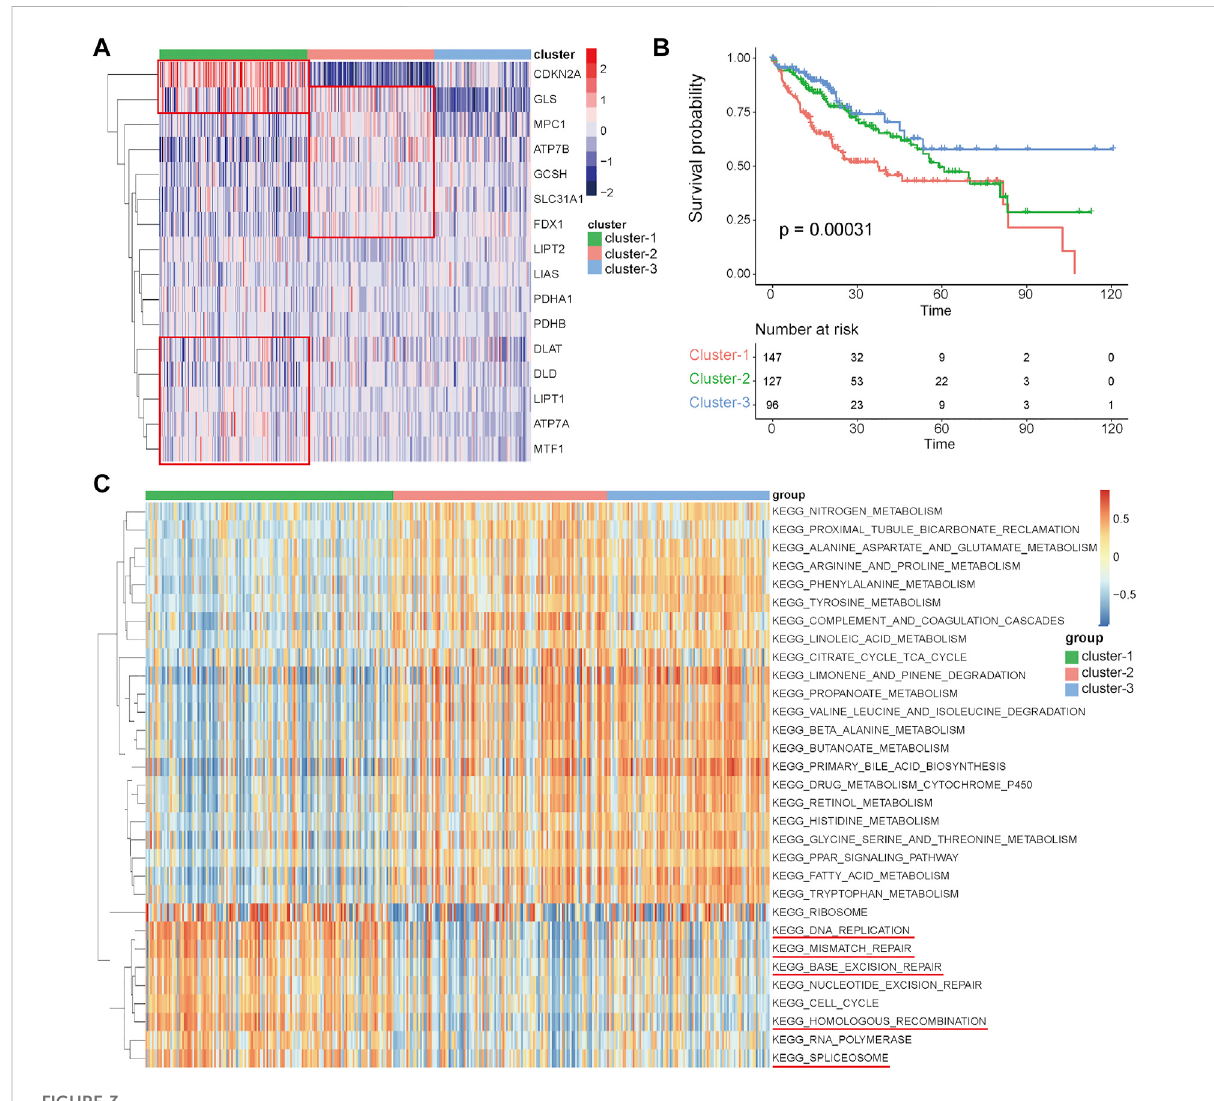
FIGURE 3 Identi fi cation of distinct expression patterns and analysis of their prognostic and functional characteristics in the TCGA-HCC cohort. (A) Unsupervised clustering of HCC patients based on the 16 cuproptosis-related genes. (B) Survival analyses for the three distinct expression patterns. (C) GSVA results showing the functional characteristics in the three